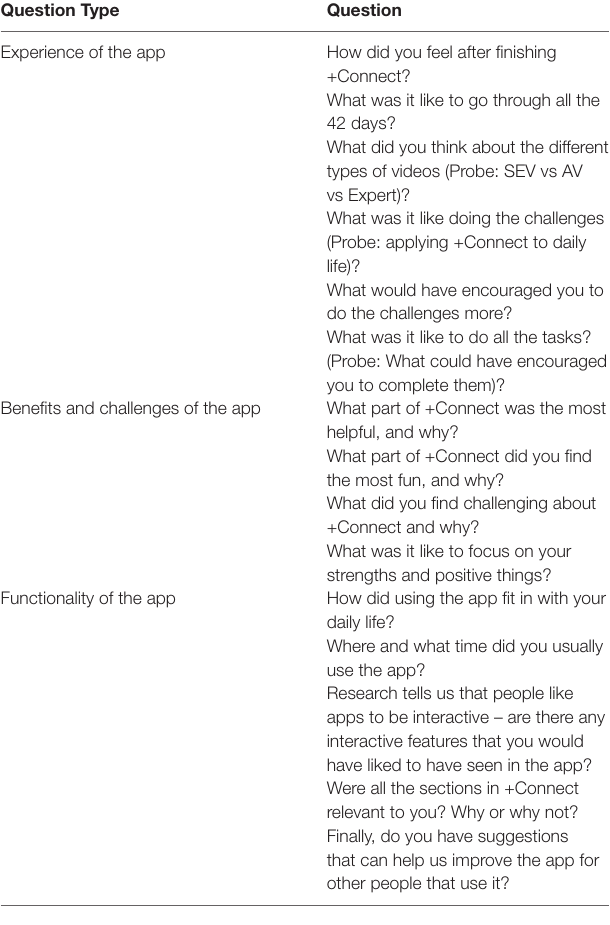
TABLE 3 | Semi-structured interview